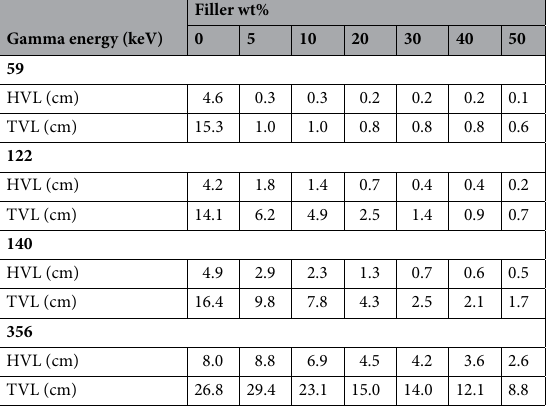
Table 7. HVL and TVL data for different filler levels of PC/Bi 2 O 3 nanocomposites.